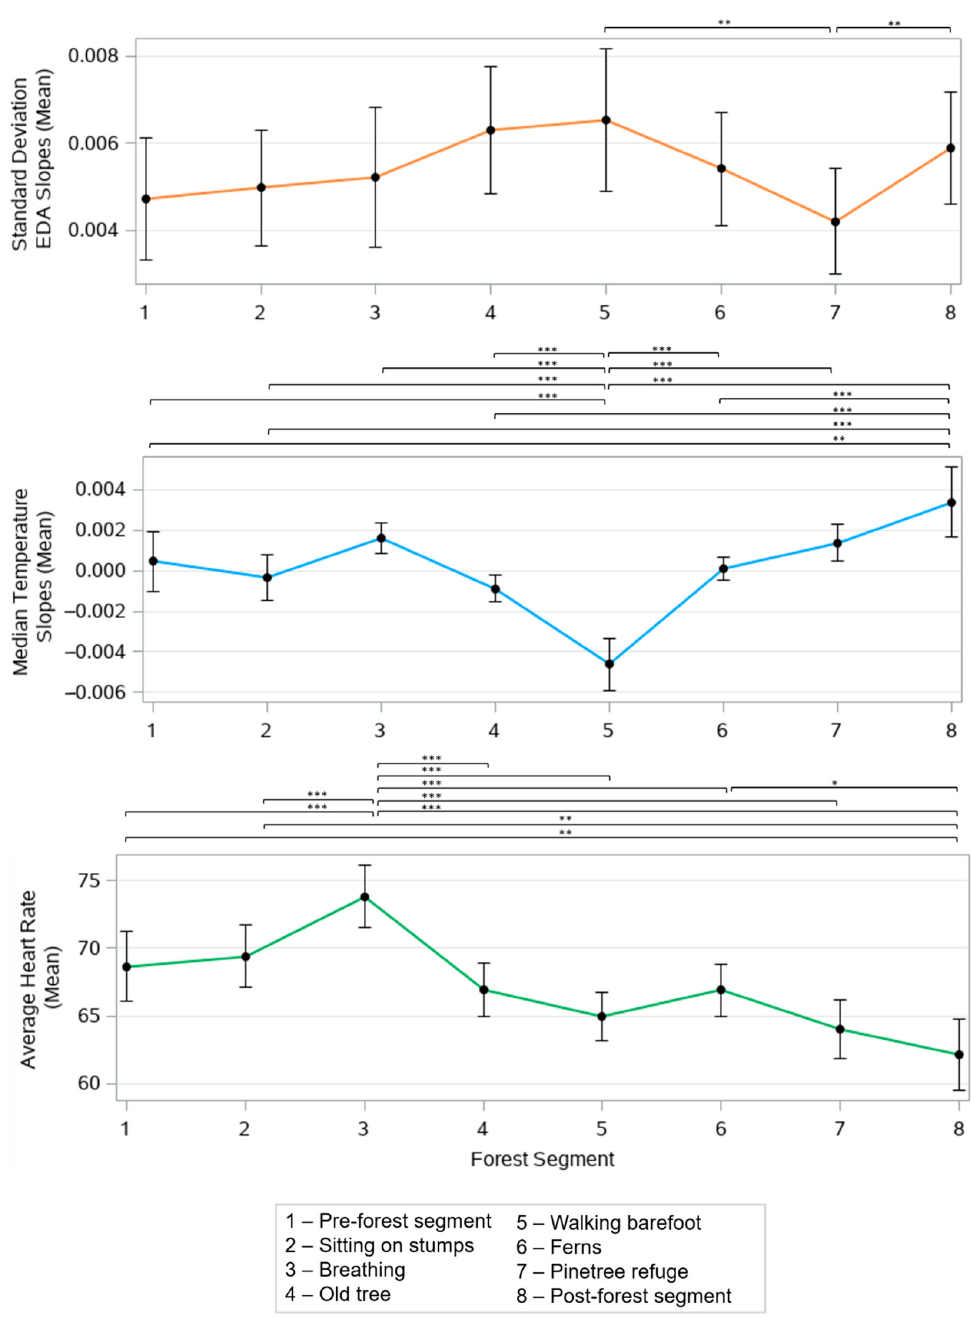
Figure 4. Effect of forest bathing on the mean standard deviation of the EDA slopes, mean of the median temperature slopes, and mean average heart rate across all forest activity segments. * p < 0.05, ** p < 0.01, *** p < 0.001, Bonferroni adjusted p -values.